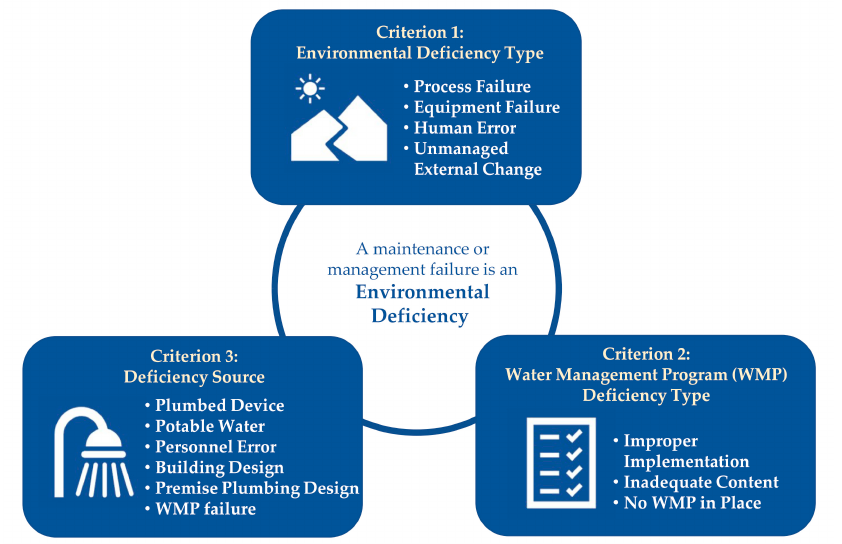
Figure 1. Each environmental deficiency is classified using three criteria .